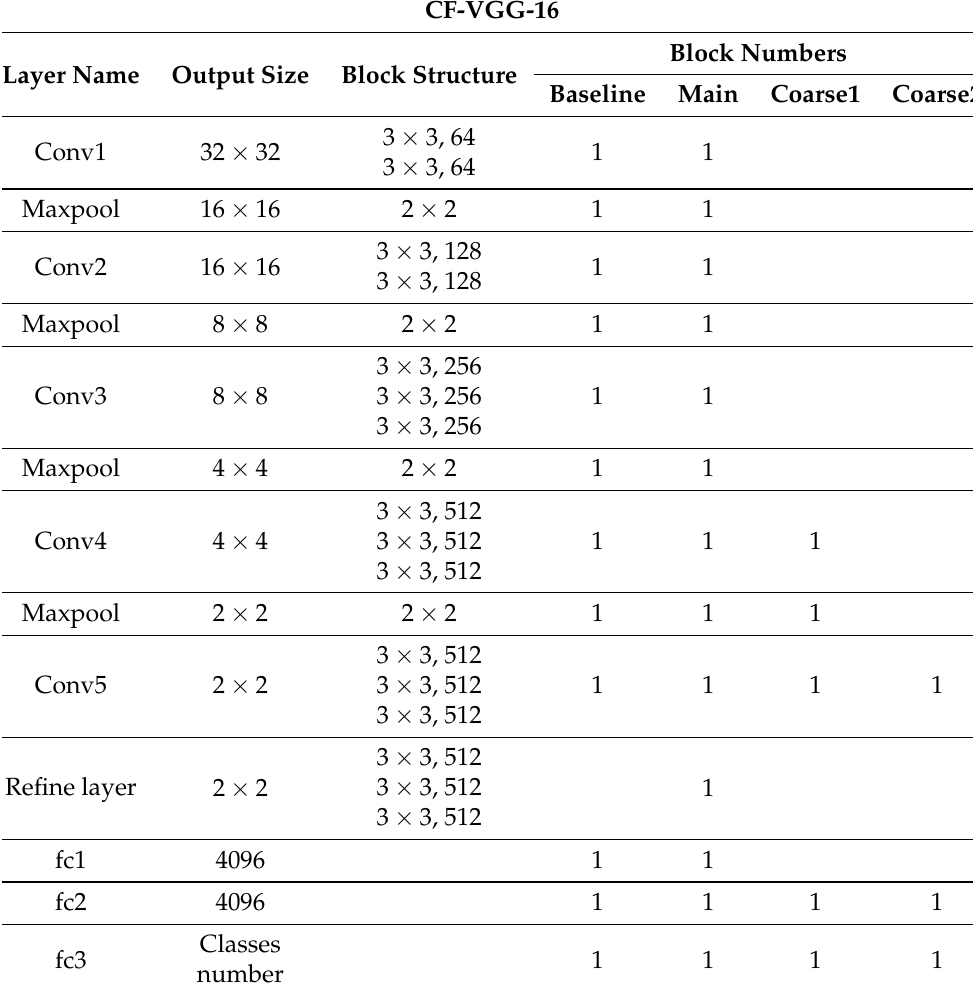
Table 1. Structure of the CF-VGG-16 model for CIFAR 100 dataset. Since the CIFAR image is very small, the last max-pooling layer of VGG-16 was not used.